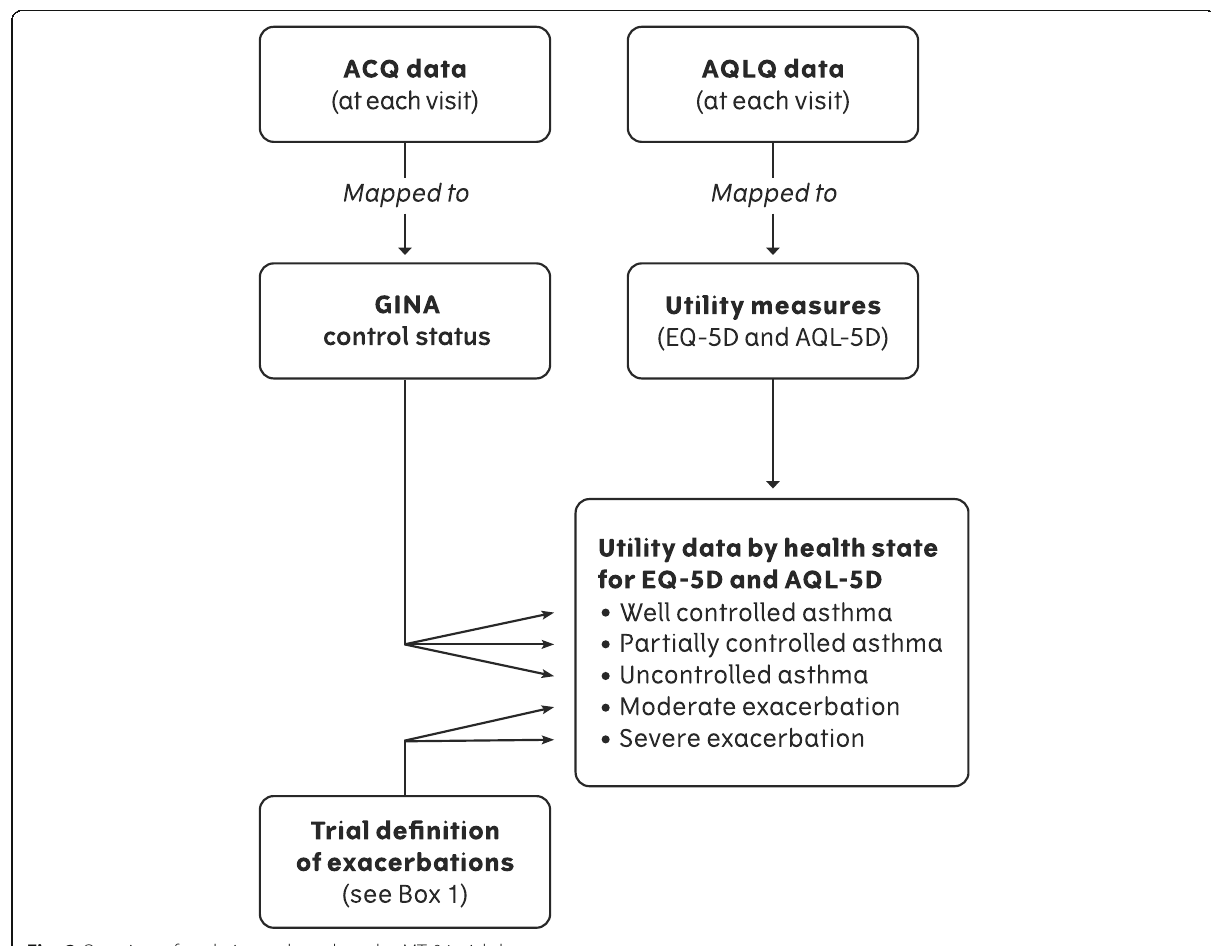
Fig. 2 Overview of analysis conducted on the MT-04 trial